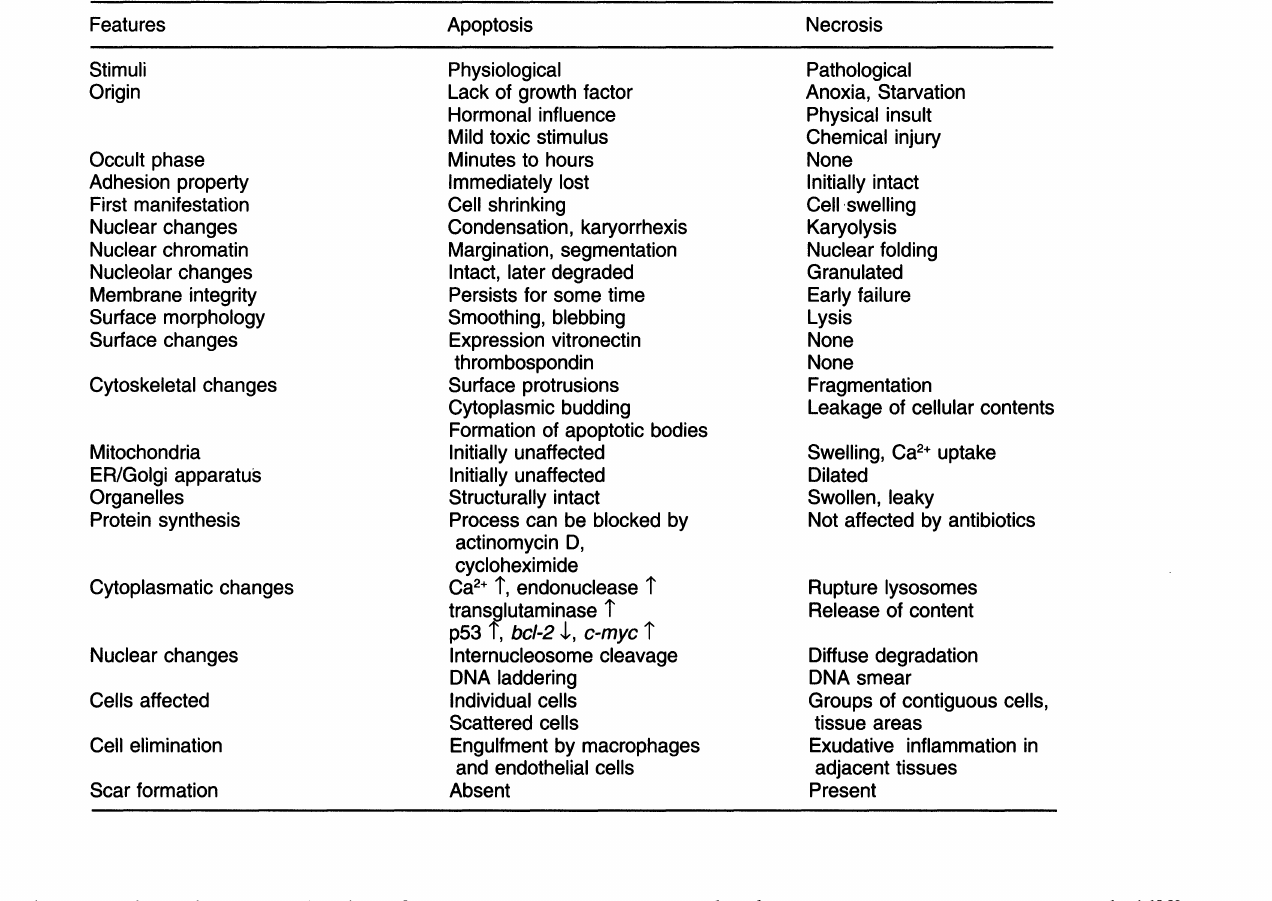
Table 1. Morphological and biochemical differences between apoptosis and necrosis